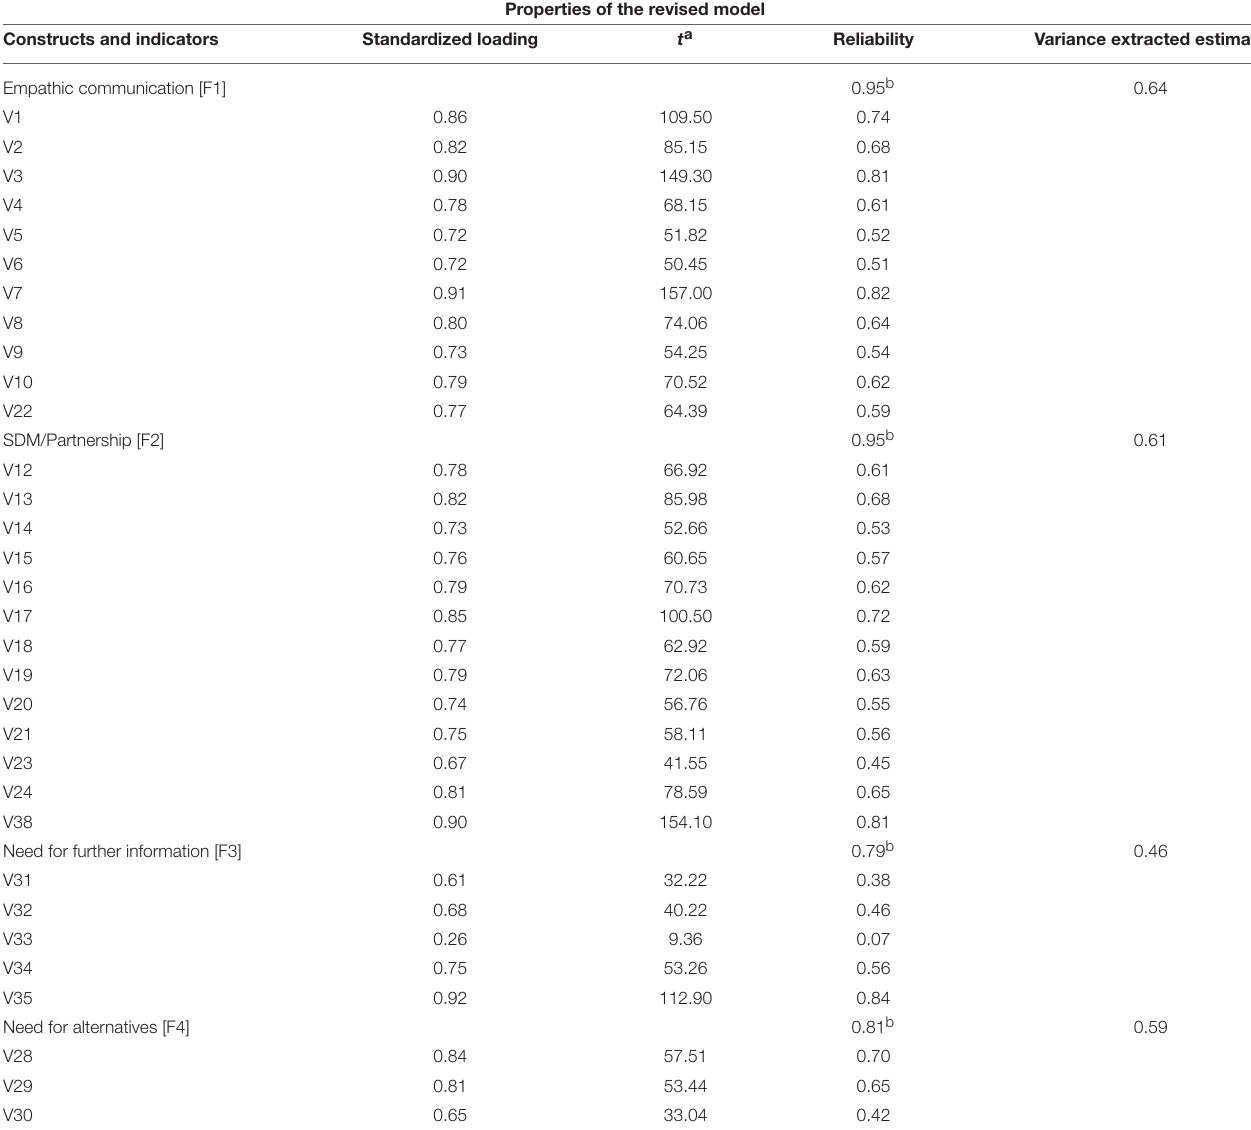
TABLE 4 | Properties of the structural equation model with four latent factors describing pet owners’ perception of communication with their